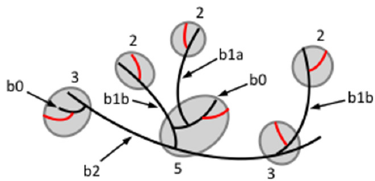
Figure 3. Chain types and building blocks in an isolated typical “cluster”. a-Chains are shown in red and b-chains ( black ) are numbered based on the number of inter-block segments they are involved in. Building blocks are encircled ( grey ) and numbered according to the number of chains they